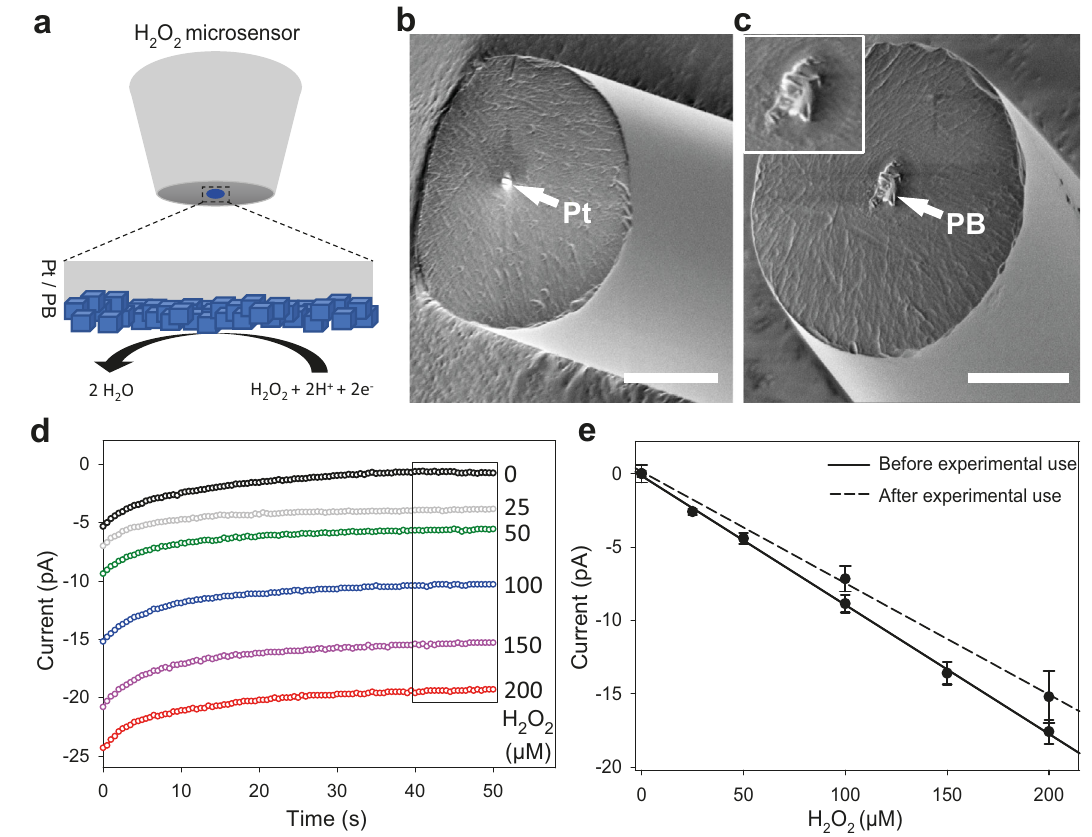
Fig. 3| Characterization ofH 2 O 2 microsensors.a Schematicprincipleof Prussian bluebasedH 2 O 2 microsensor. b , c arescanningelectronmicroscopeimagesofaPt ultramicroelectrode and the Prussian blue modi fi ed Pt ultramicroelectrode. Scale bars,10 µ m( b );10 µ m( c ). d AmperometricresponseofaH 2 O 2 microsensorto0 µ M (black,), 25 µ M (gray),50 µ M (green), 100 µ M (blue), 150 µ M (magenta) and 200 µ M